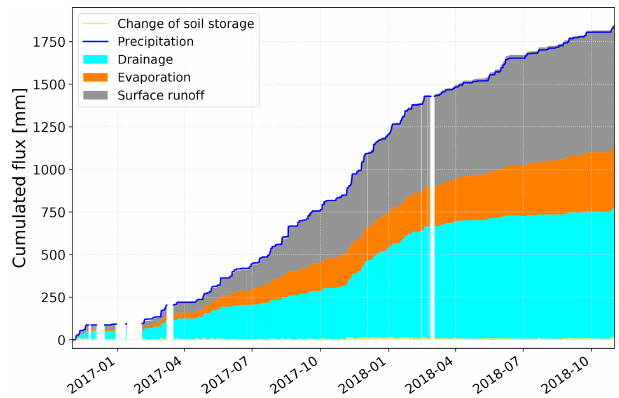
Figure 9. Cumulated water fluxes of the entire water balance for plot